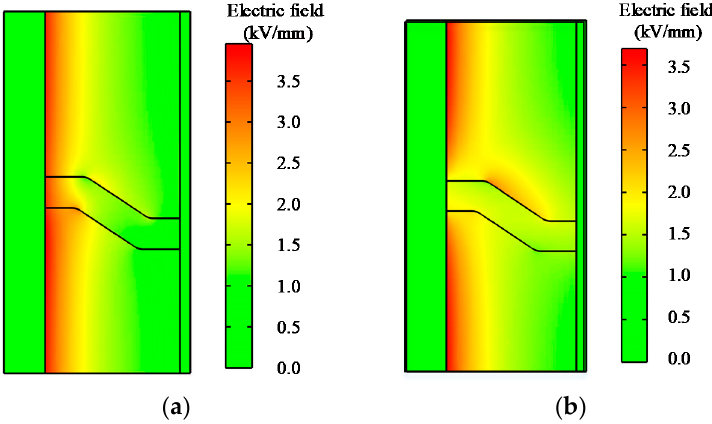
Figure 6. Electric field distribution around the pure epoxy and aged SiC/epoxy micro-composite spacer: ( a ) pure epoxy; ( b ) 1080 h-aged SiC/epoxy micro-composites.